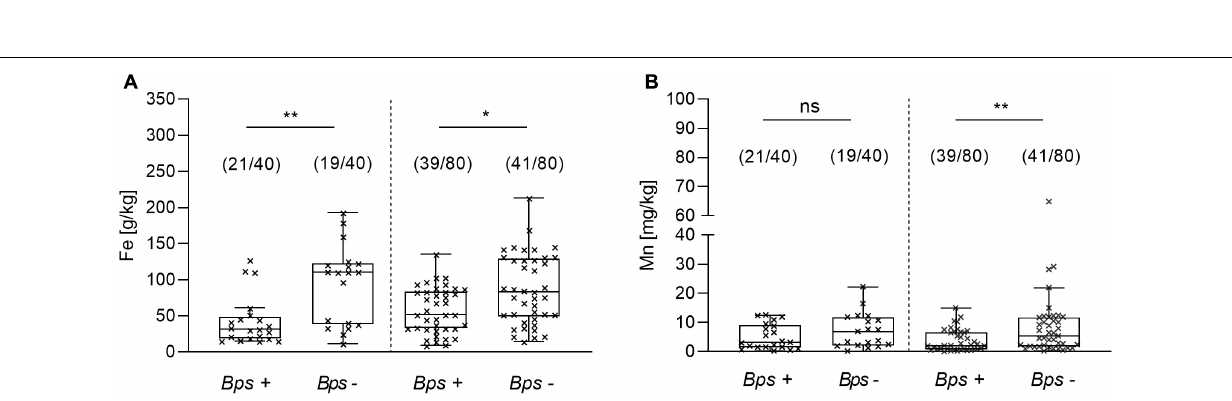
FIGURE 7 | Seasonal difference in the burden of B. pseudomallei positive soil samples in paddy and other field types. Dot plots show B. pseudomallei genome equivalents (GE) per gram of soil detected in paddy and other fields sampled (Kruskal–Wallis; ns, not significant; * p < 0.05, *** p < 0.001, **** p < 0.0001). Samples that became positive in subsequent enrichment culture are marked with an asterisk in the data set. The measured molecular load of the culture positive soil samples was 1.95 × 10 5 genome equivalent for the paddy site S14 and 3.76 × 10 6 genome equivalents in the uncultivated site S3. Boxes line values from the 25th to 75th percentiles of a data set; the vertical line in a box plot marks the median value. The whiskers from the lower and upper quartile represent 1.5 times the interquartile range.